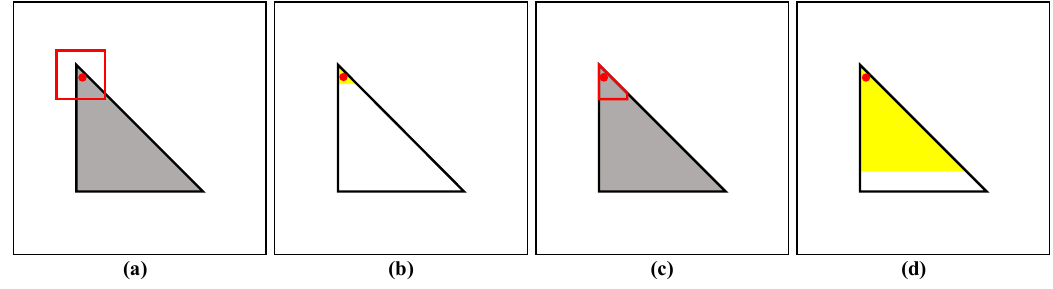
Figure 1. Homogeneous pixel selection of regular and SA matching patches near corner point, respectively. If it is used by the regular patches marked by red box in ( a ), the selected homogeneous pixels highlighted with yellow are very small in ( b ). On the contrary, based on SA matching patches in ( c ), the selection capability is flexible and the selected homogeneous pixels are much large in ( d ).